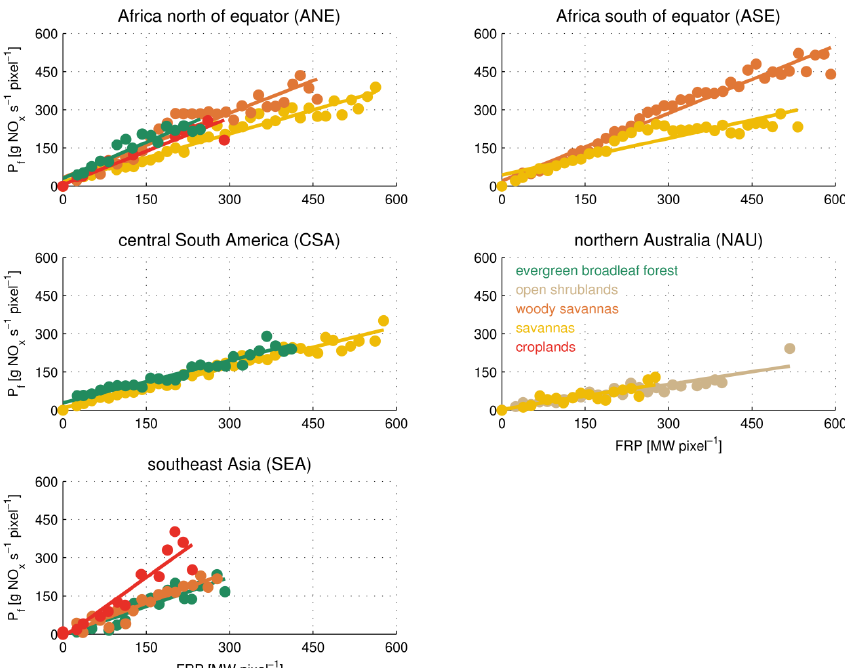
Figure 11. Biome-specific FERs of NO x , averaged via the binning method, for the selected regions. Here, the best fitting least-squares regression lines of the morning observations (GOME-2 vs. MODIS Terra) are shown for evergreen broadleaf forest (green), open shrublands (beige), woody savannas (orange), savannas (yellow), and croplands (red). The binning method used for the averaging is described in the text.